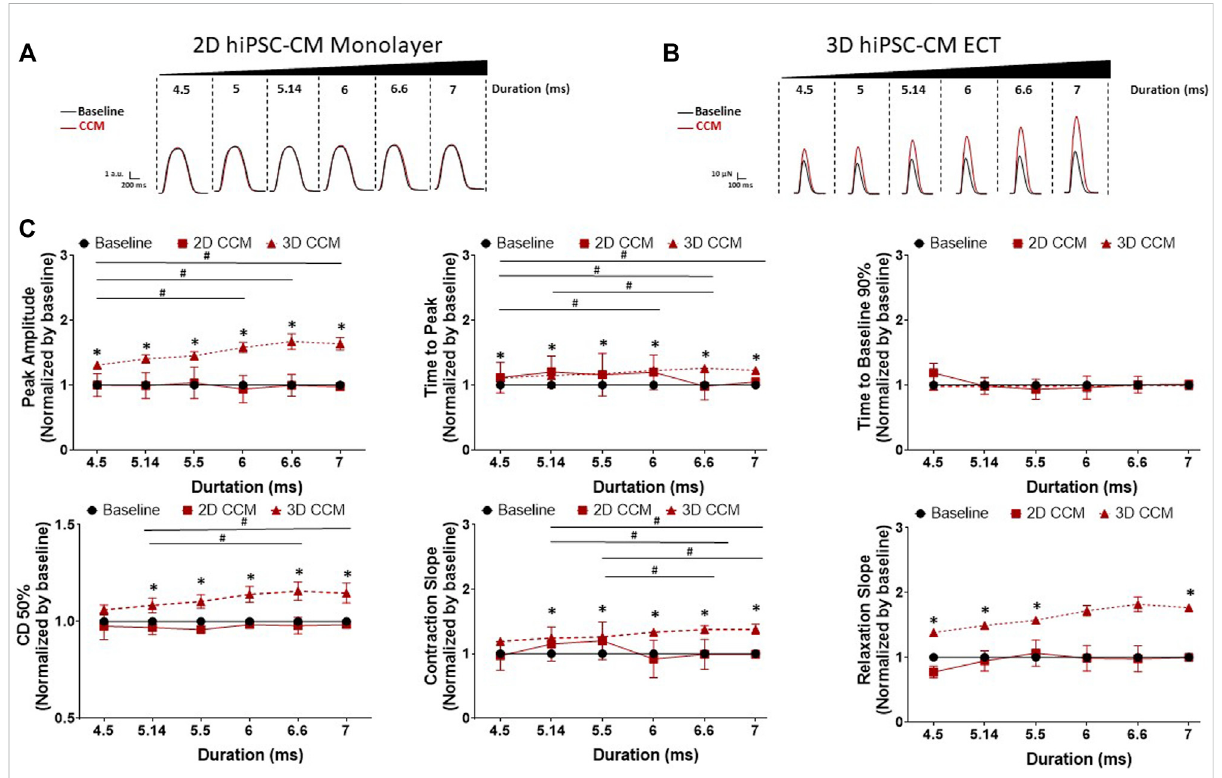
FIGURE 5 Effect of CCM pulse duration on 2D and 3D hiPSC-CM contractile properties (A) Representative contraction traces for baseline (i.e., fi eld stimulation pacing, 1 Hz). and CCM for 2D monolayer hiPSC-CMs and (B) 3D ECTs (C) Summary data graphs. Data are mean ± SEM. n = 3 – 6 per group. * p < 0.05 (3D vs. BL), # p < 0.05 (3D vs. 3D), + p < 0.05 (2D vs.